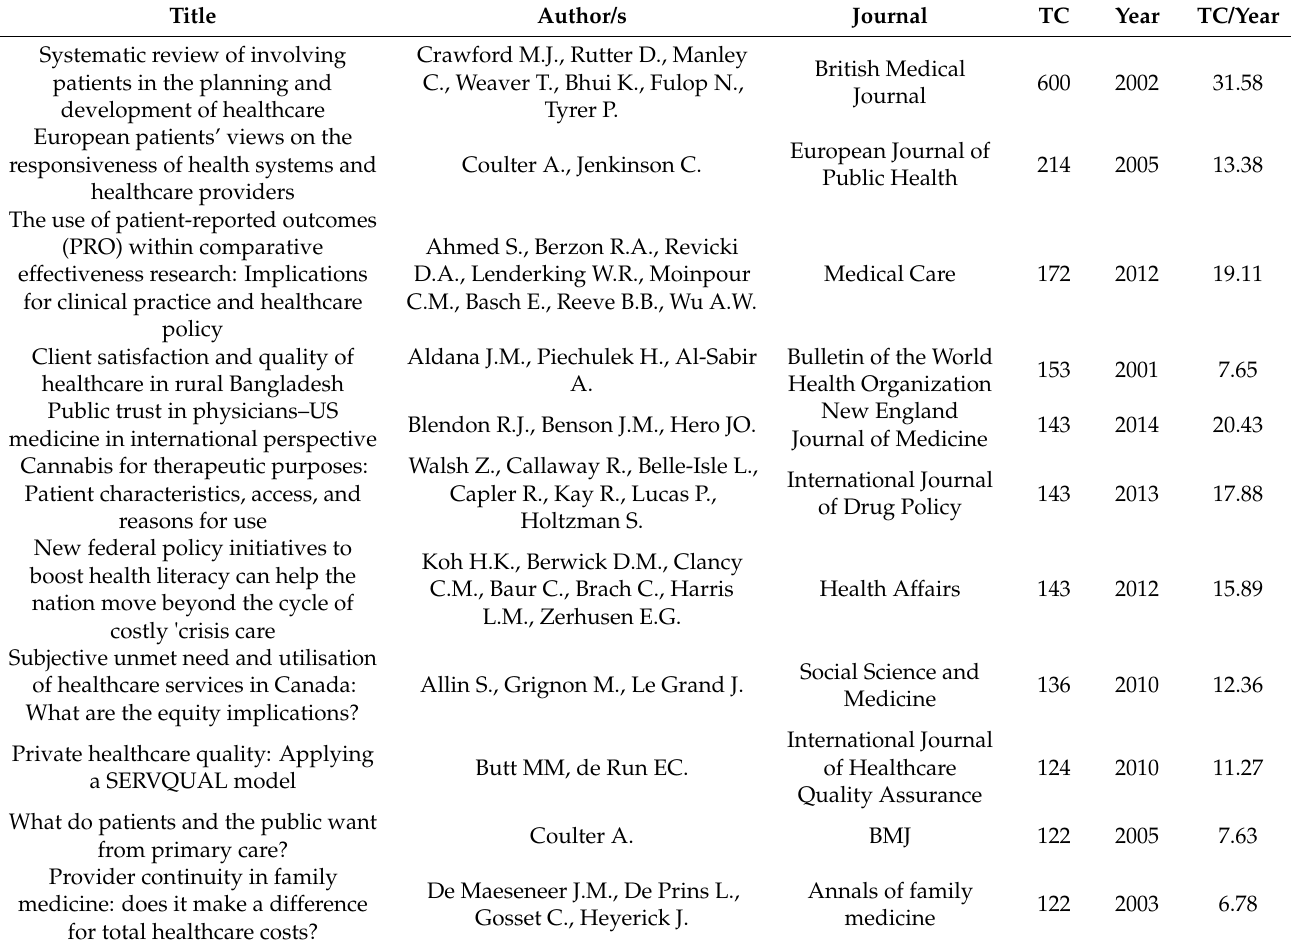
Table 7. The top 11 most cited articles on PS and HP